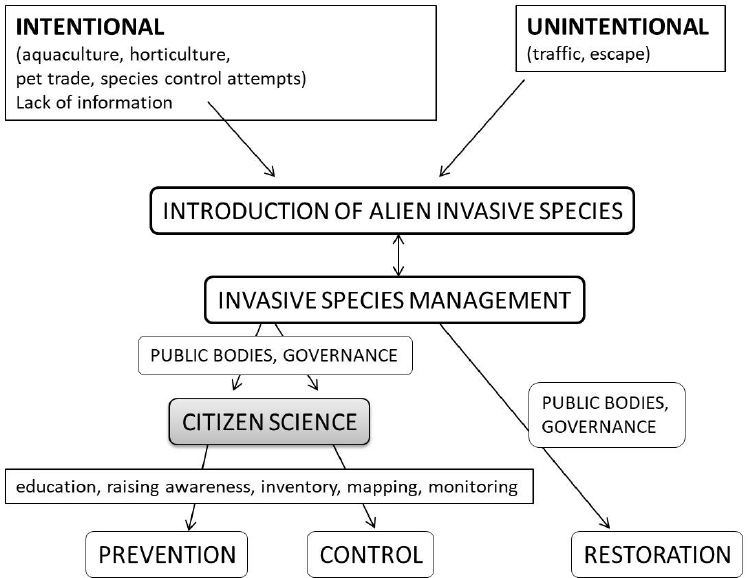
Figure 1. Invasive species introduction, management, and response through citizen science.